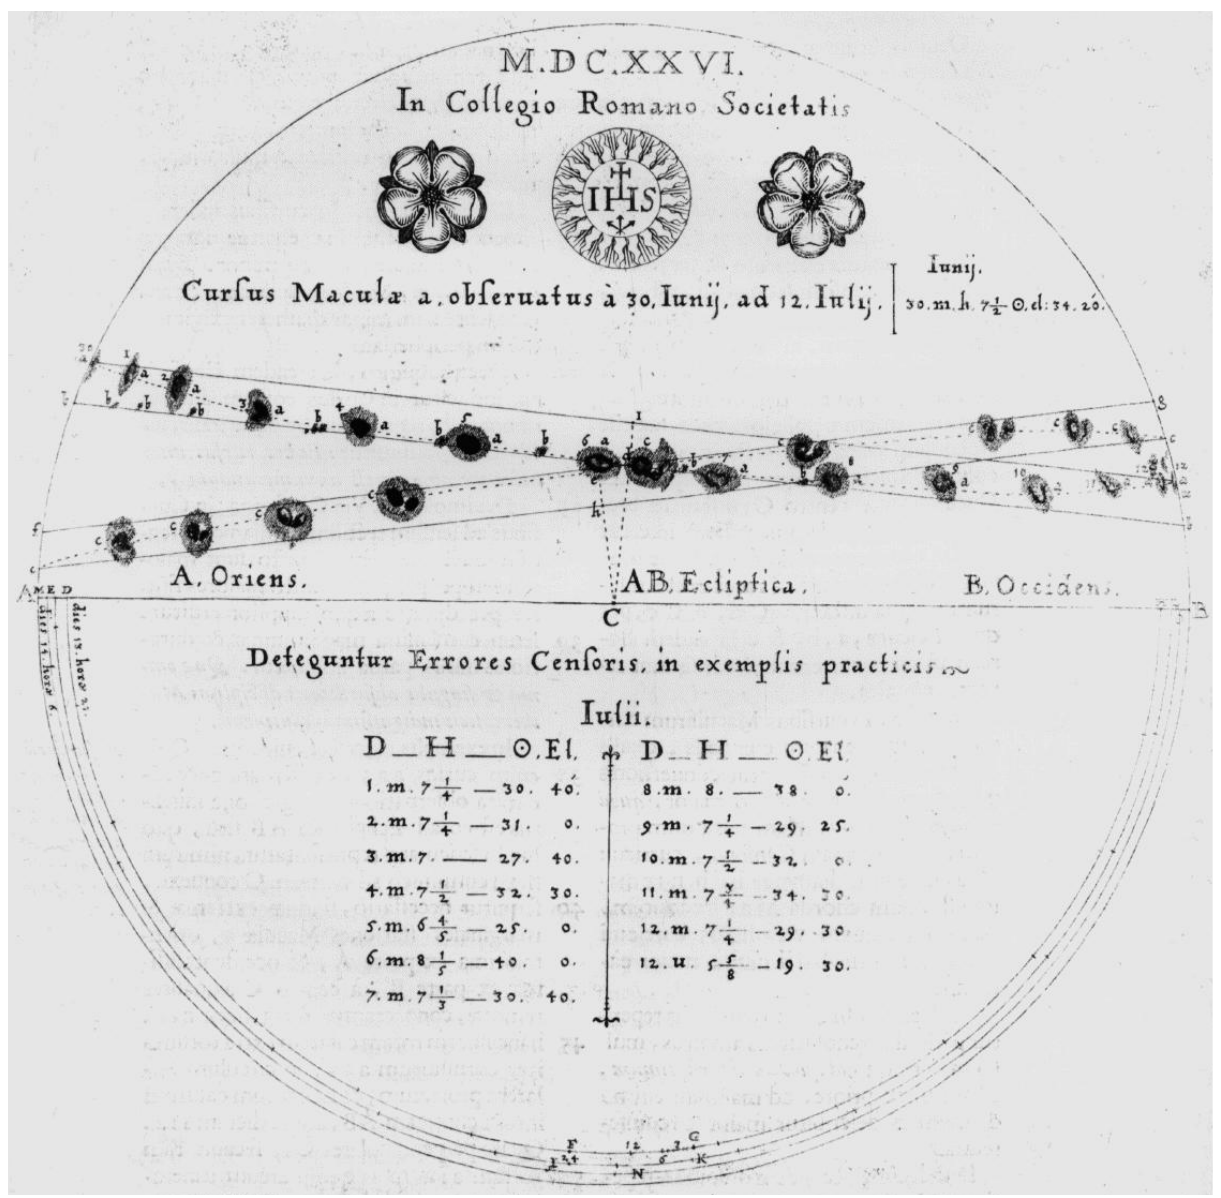
Fig. 5. The daily progression of sunspots across the solar disk (Curve a) during the interval AD 1626 June 30–July 12 (Scheiner, 1630). (Curve c refers to the interval AD 1625 December 22–1626 January 1.) The large sunspot in the northern half of the solar disk that crossed the central meridian on July 6 (Curve a) is much more likely to be associated with the Japanese auroral observation on July 10 (see Table 1) than is the apparently spurious unaided-eye Chinese sunspot observation on June 29 (see Table